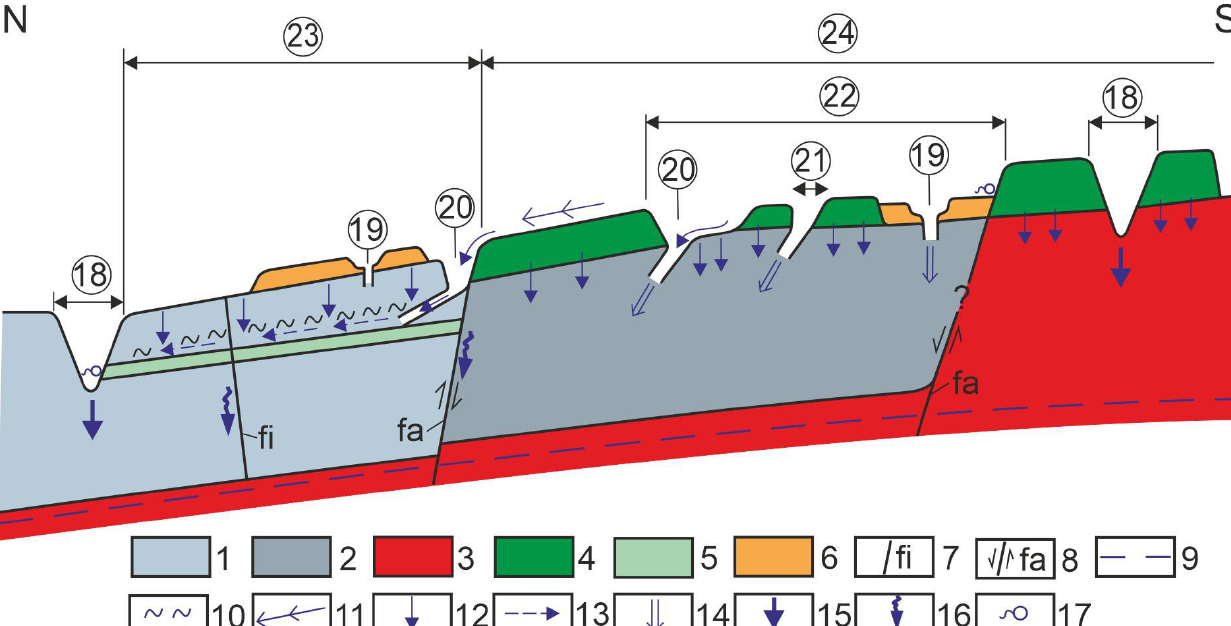
Figure 16. Semi-closed epigene karst system in cross-section. Legend: 1. Young limestone, 2. Older (Jurassic, Triassic) limestone, 3. Main dolomite, 4. Basalt, 5. Impermeable intercalation, 6. Permeable cover (loess), 7. Fracture, 8. Fault, 9. Regional groundwater level, 10. Level of perched water table, 11. Surface stream, 12. Infiltration, 13. Water motion above impermeable intercalation, 14. Local water inflow, 15. Linear infiltration, 16. Infiltration along fracture, fault, 17. Spring, 18. Valley, 19. Subsidence doline, 20. Ponor with blind valley, 21. Caprock doline, 22. Complex karst system, 23. Epigene local karst system, 24. Epigene regional karst system.